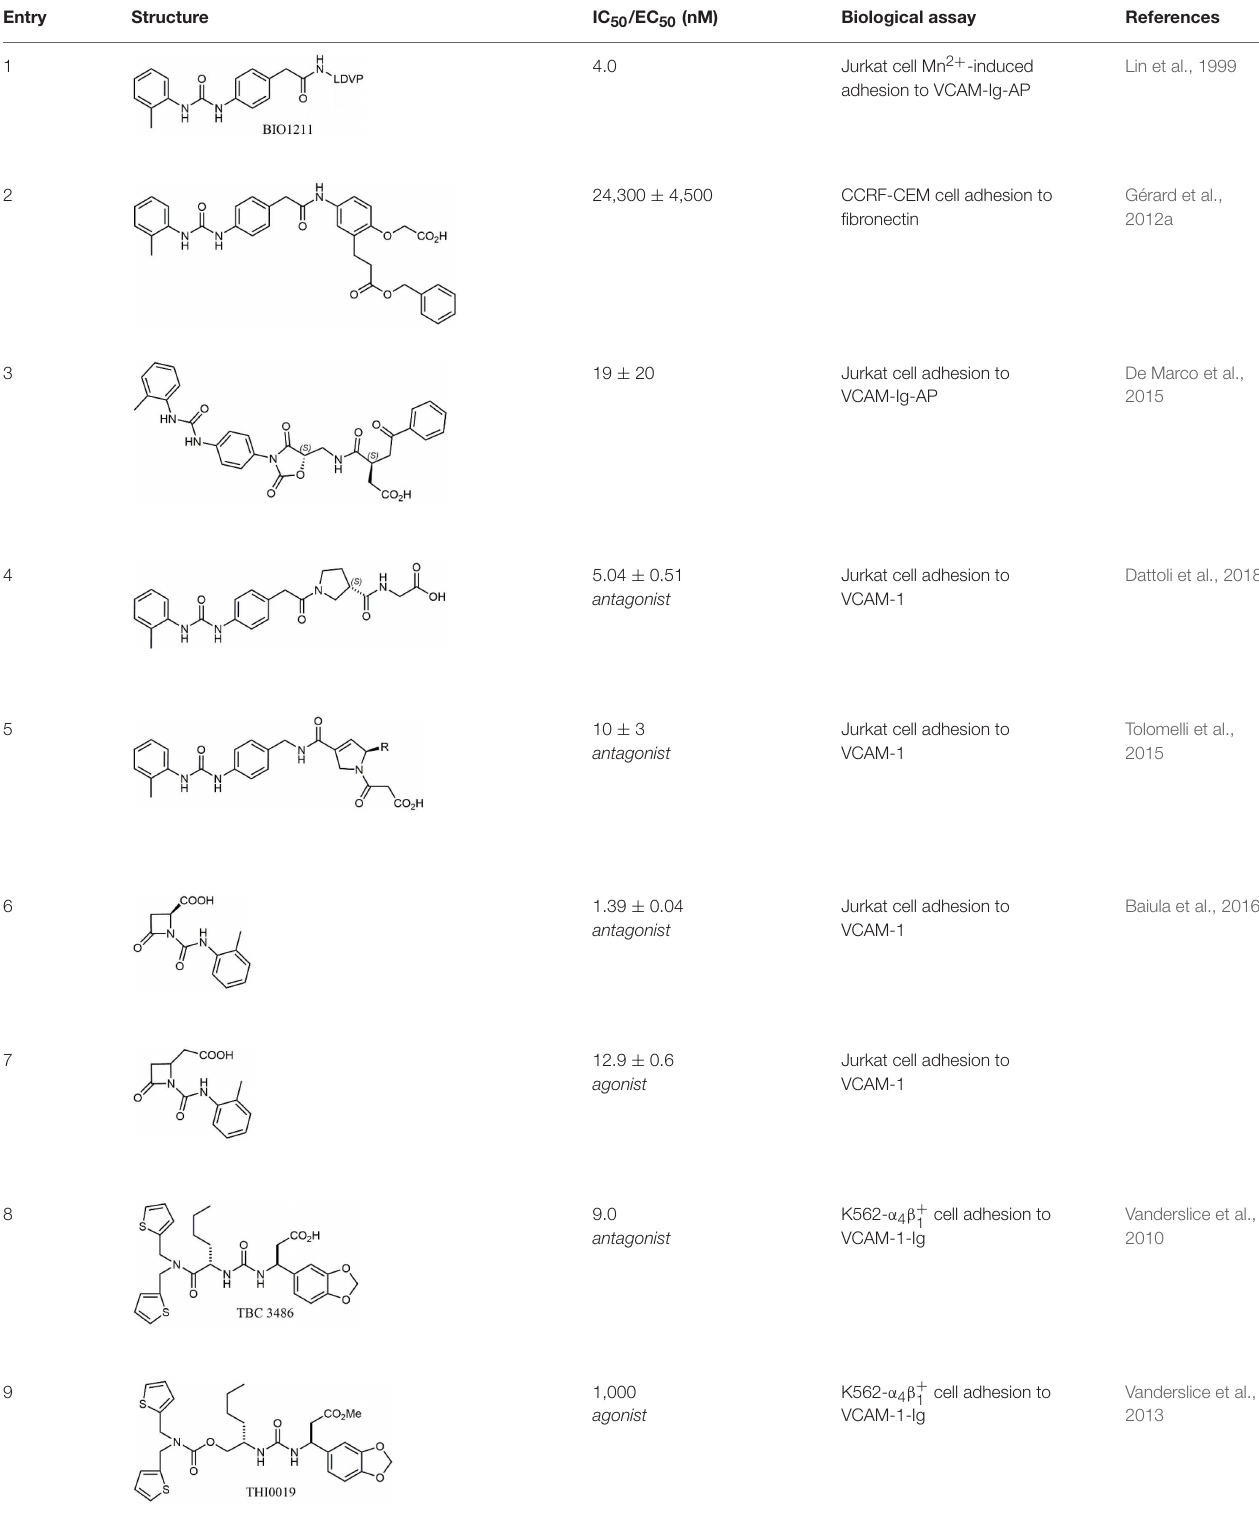
TABLE 1 | A collection of lead compounds, ligands of α 4 β 1